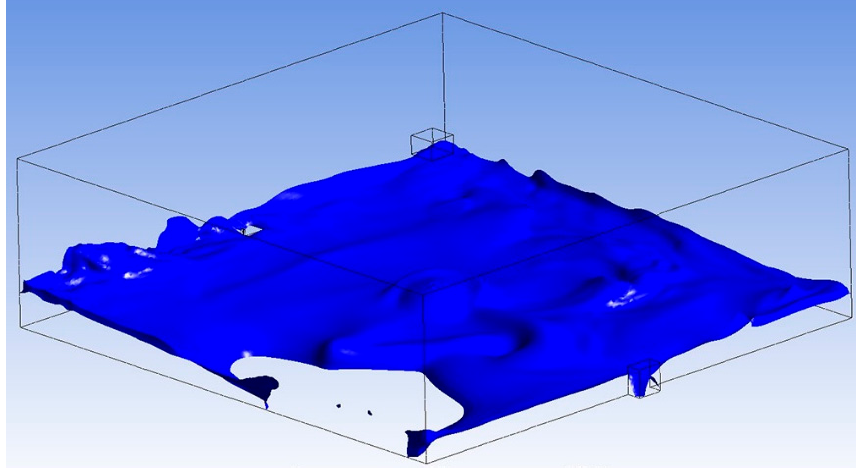
Figure 4. Iso-surface for propane representing 5% concentration of the lower explosive level (LEL).